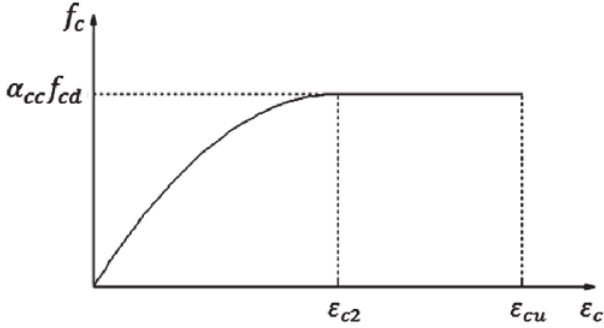
Figura 7 Seção transversal discretizada, sob rotação em torno do eixo longitudinal do pilar